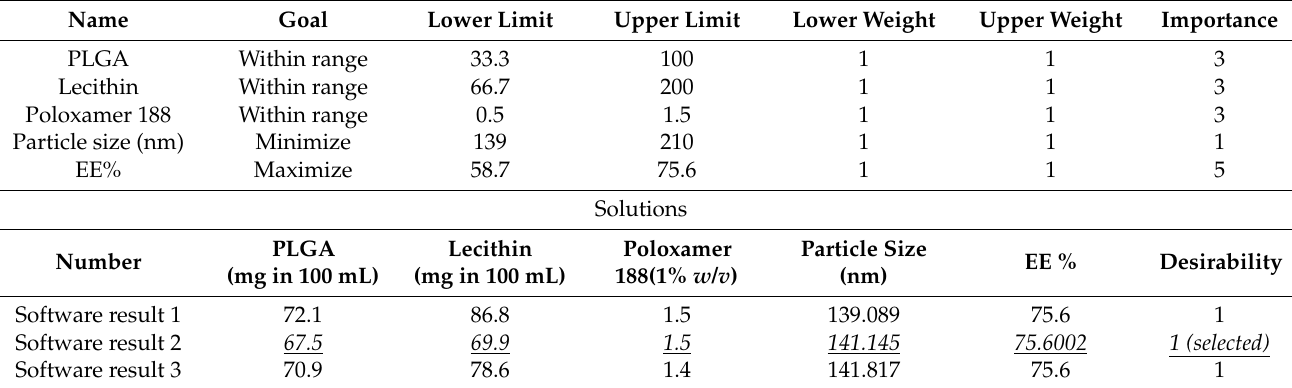
Table 4 contains data obtained from the software Design Expert, last column represents how this factor is important for optimization; 1 is most important while 5 is of least importance. Results 1, 2, and 3 were the different probabilities created by the software, which when related to runs, they expressed PLNs-11 and Result 2 was selected to be the